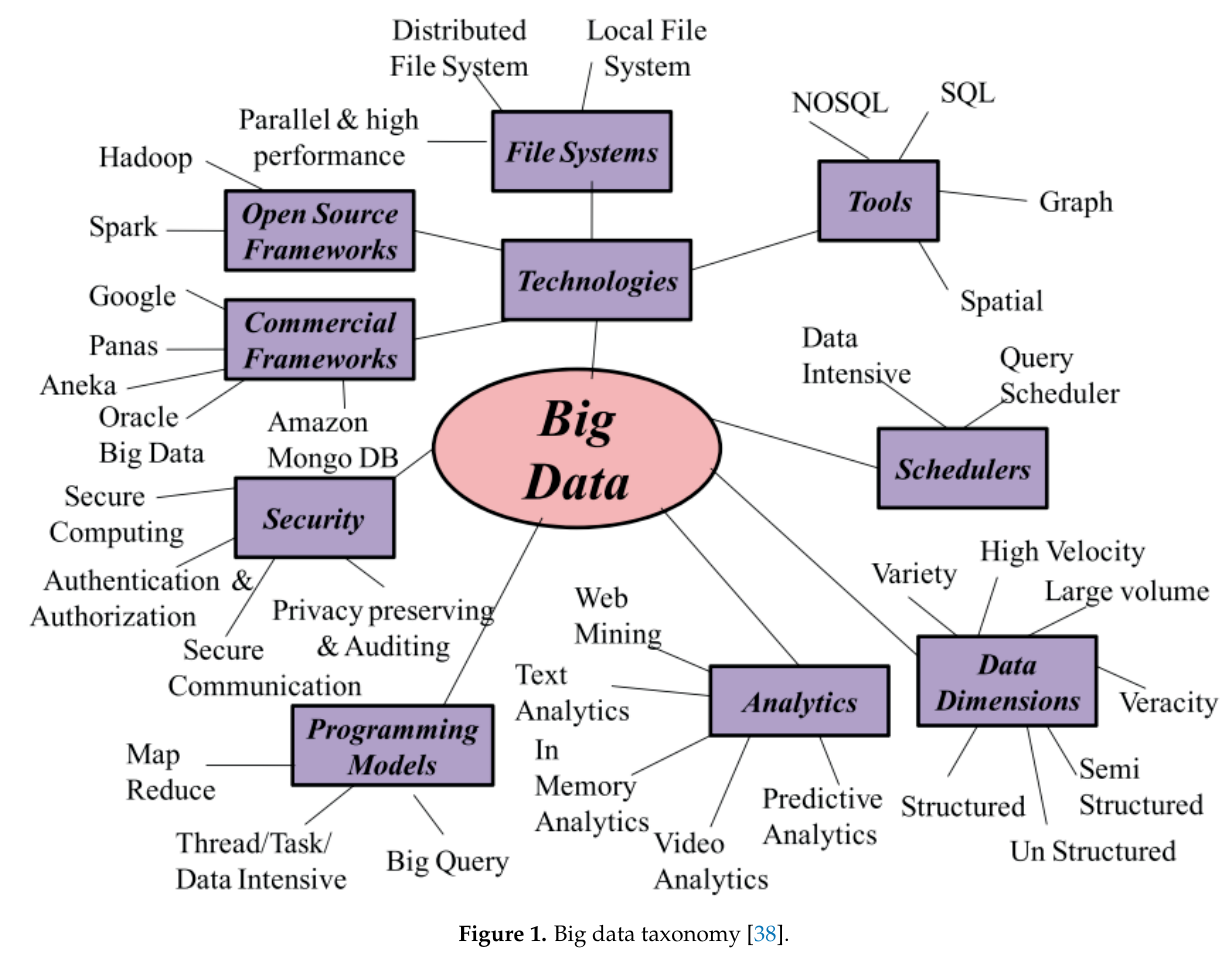
Figure 1. Big data taxonomy [38].